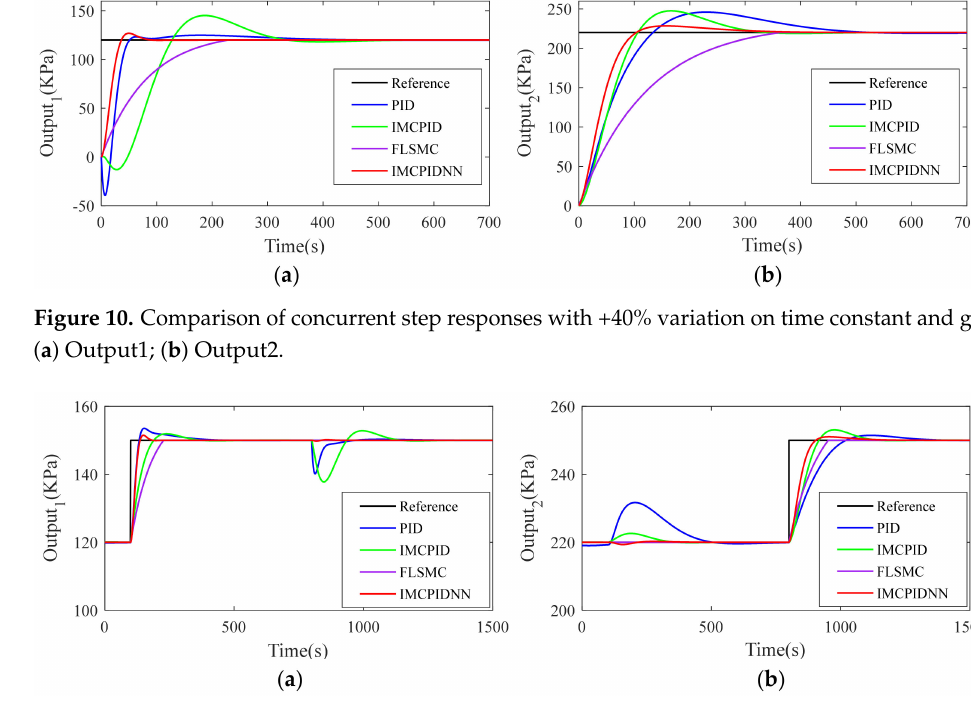
Figure 11. Comparison of sequential step responses with +40% variation on time constant and